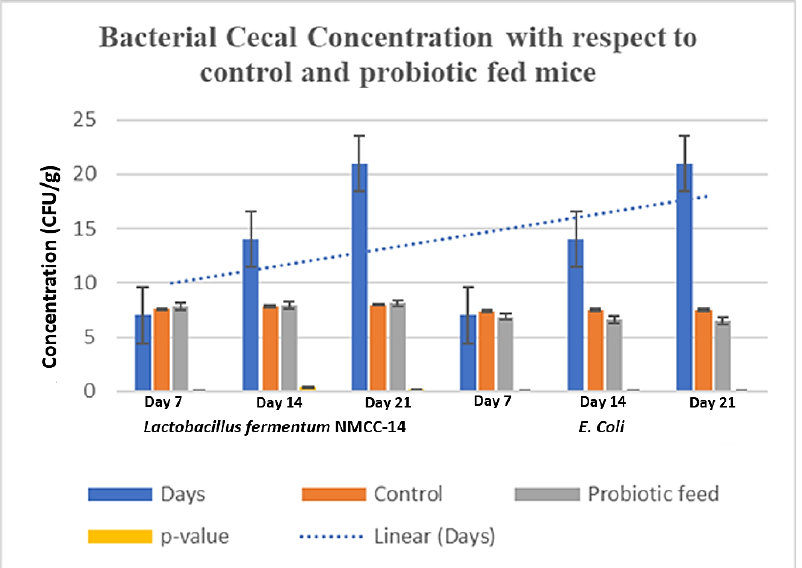
Figure 12. Cecal concentration of Lactobacillus fermentum NMCC-14 and E. coli in control and probiotic-fed mice.